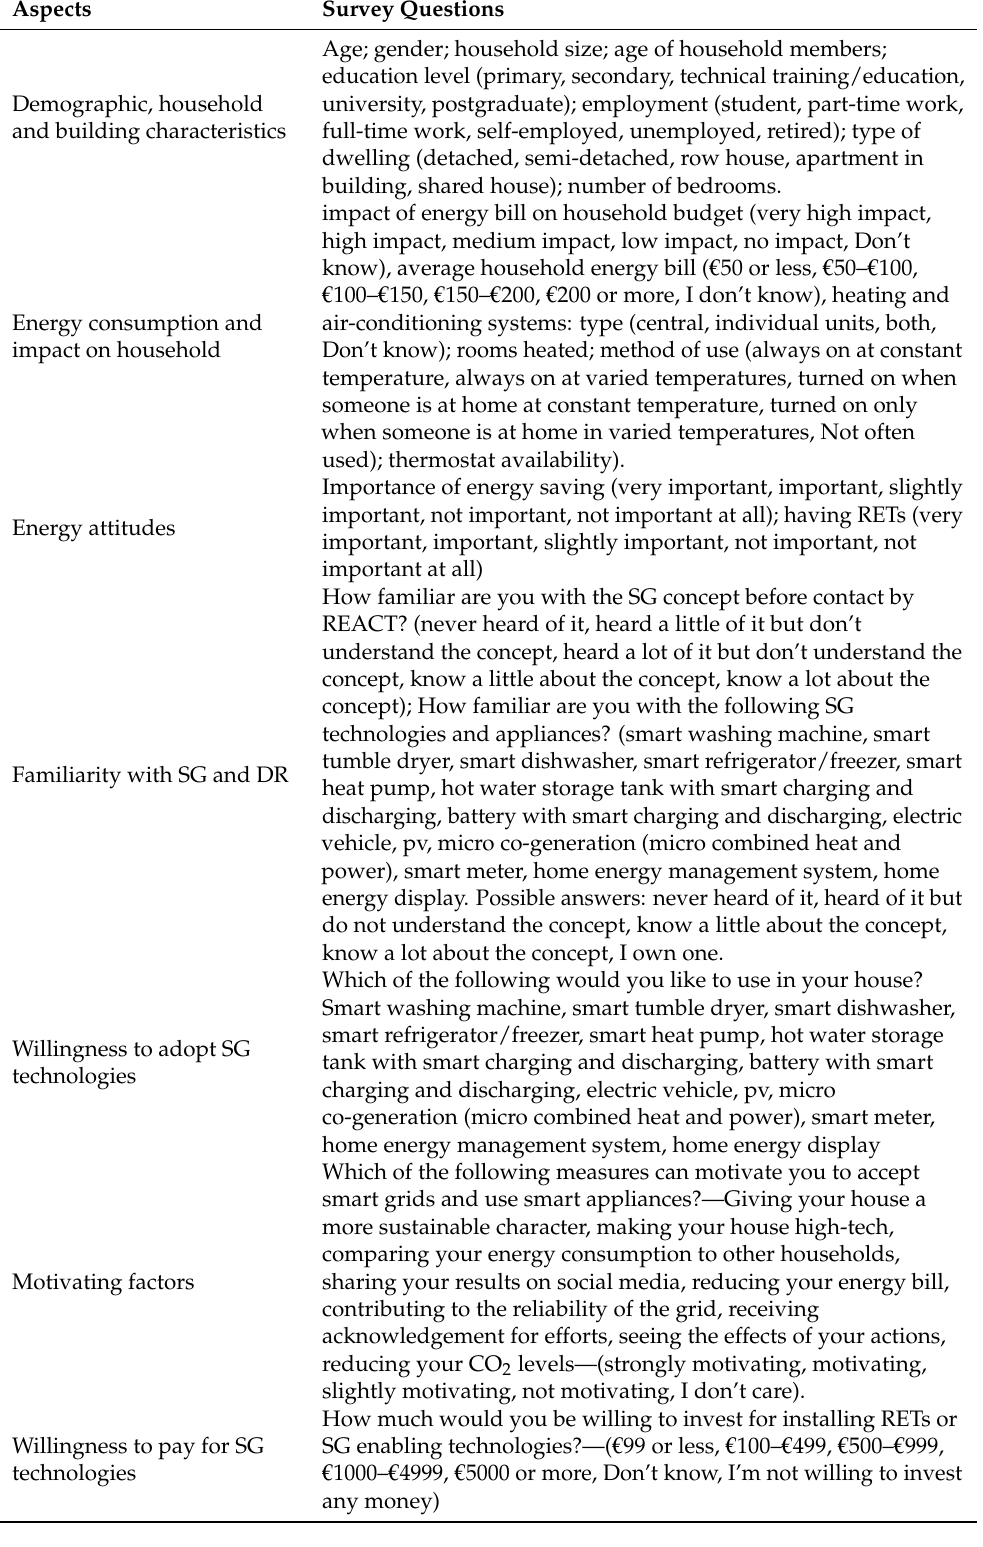
Table A1. Questions in the